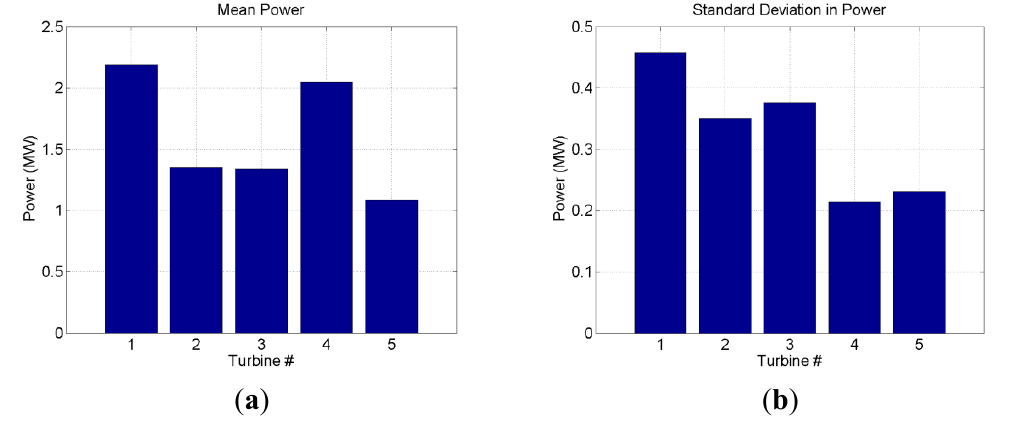
Figure 18. Mean and standard deviation of turbine power (5-Turbine Wind Farm, V Wind = 8 m/s). ( a ) Mean; ( b ) Std.